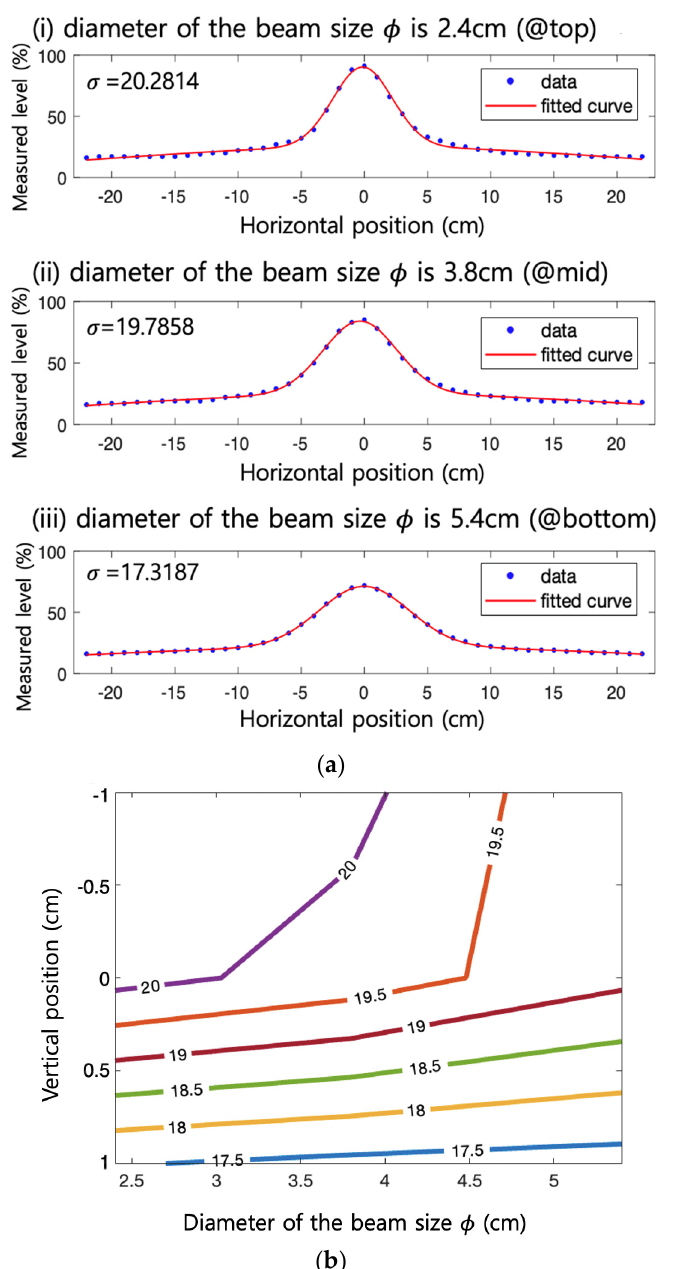
Figure 5. ( a ) Measured signal strength distribution and Gaussian fit; ( b ) overall standard deviation analysis.